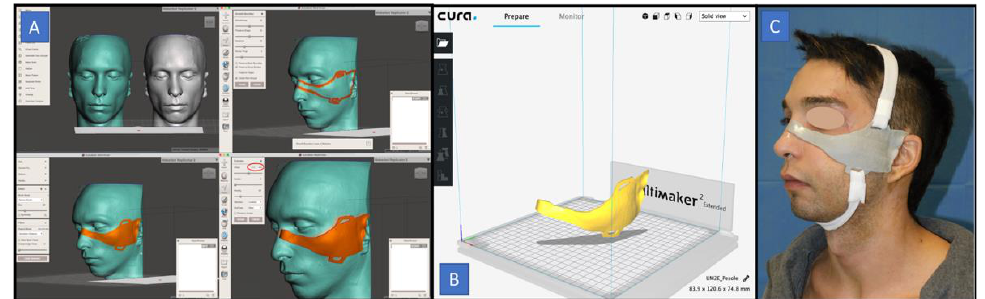
Figure 5. Editing phase of the virtual surgical planning (VSP) ( A ), completed shield ready for the 3D print ( B ), and face-shield perfectly fitted on the face of the patient ( C ).